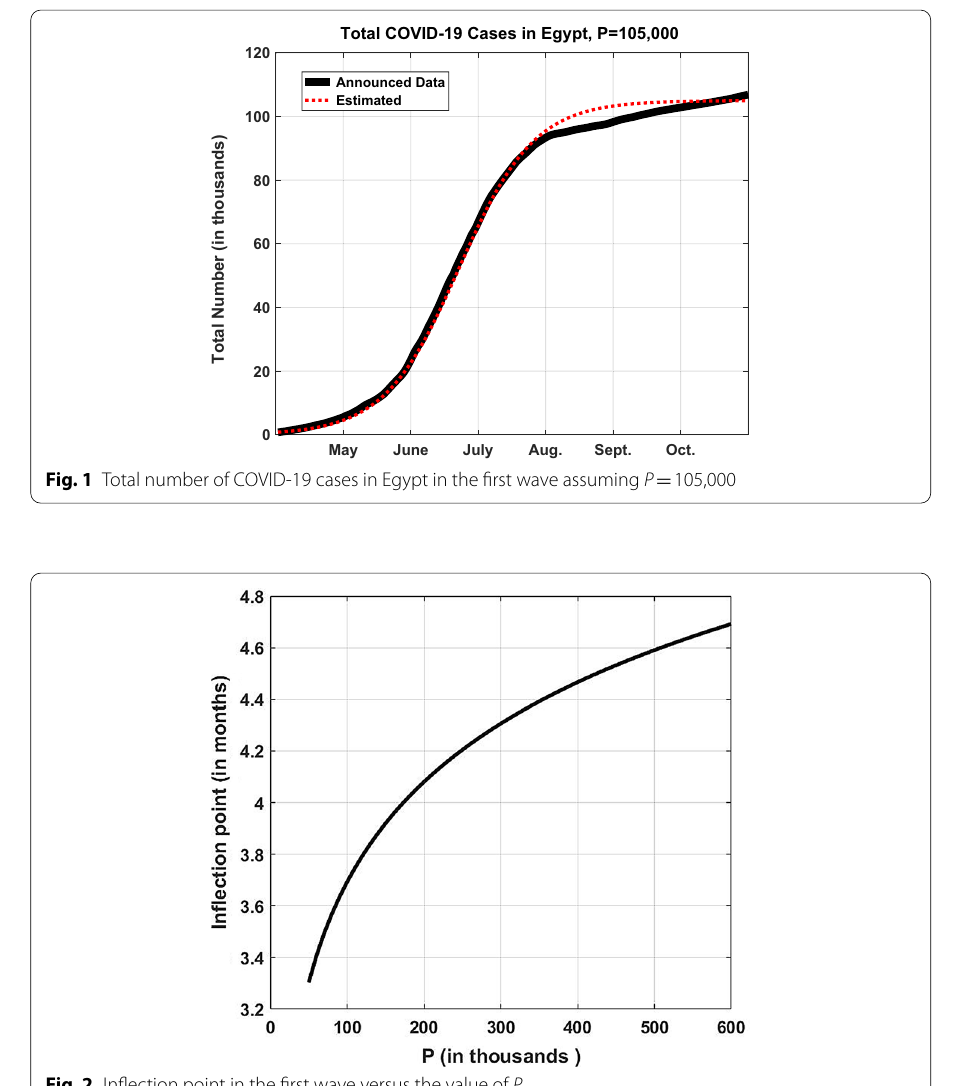
Fig. 2 Inflection point in the first wave versus the value of